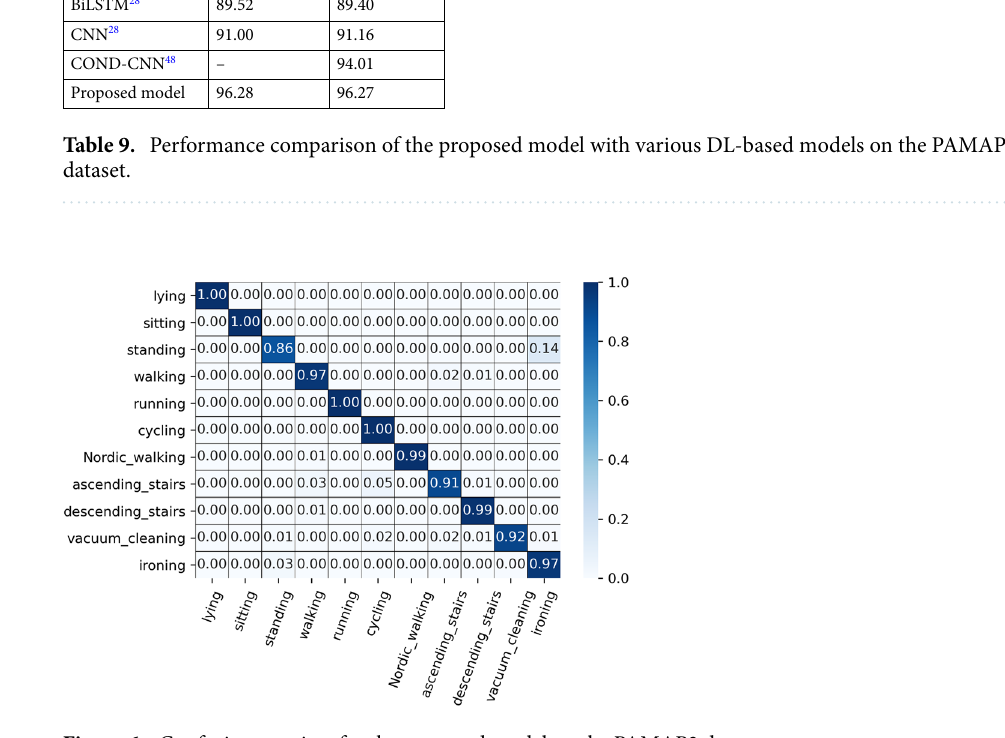
Figure 6. Confusion matrices for the proposed model on the PAMAP2 dataset .